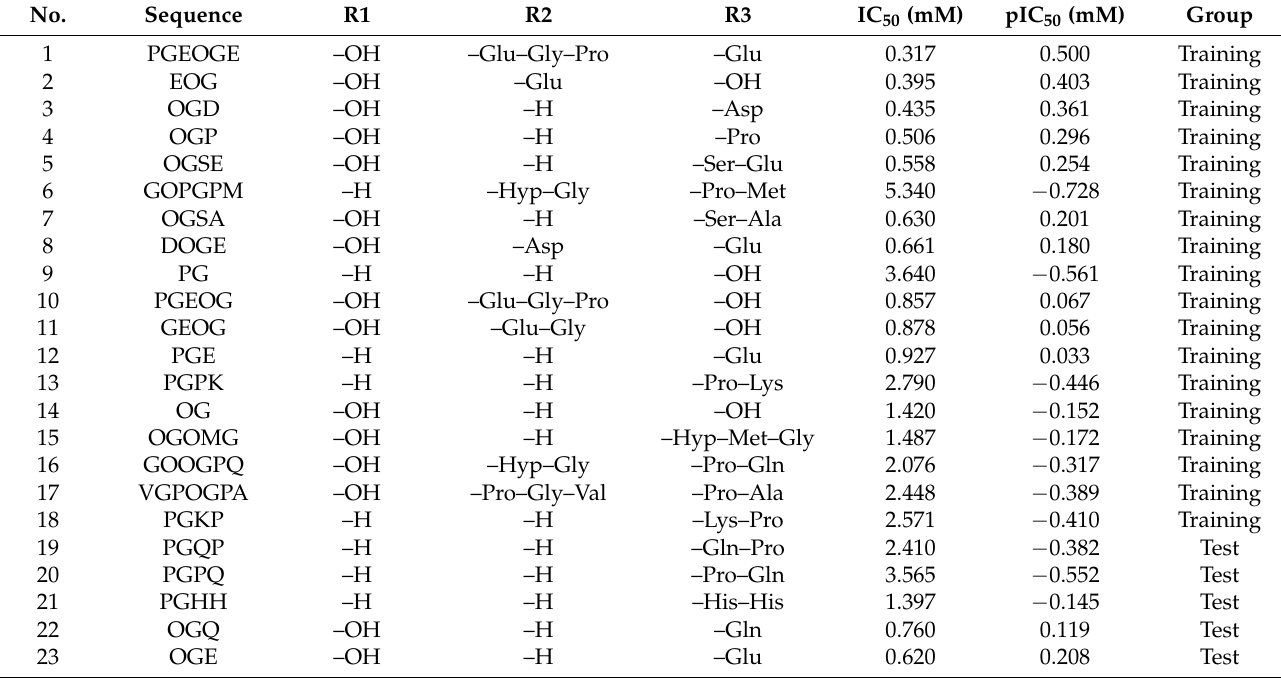
Table 1. Database of antiplatelets for 3D-QSAR